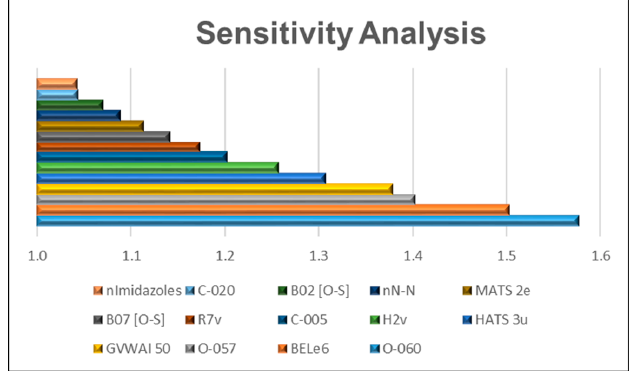
Figure 3 . Sensitivity analysis of the MD for the MLP 14-9-1 model.